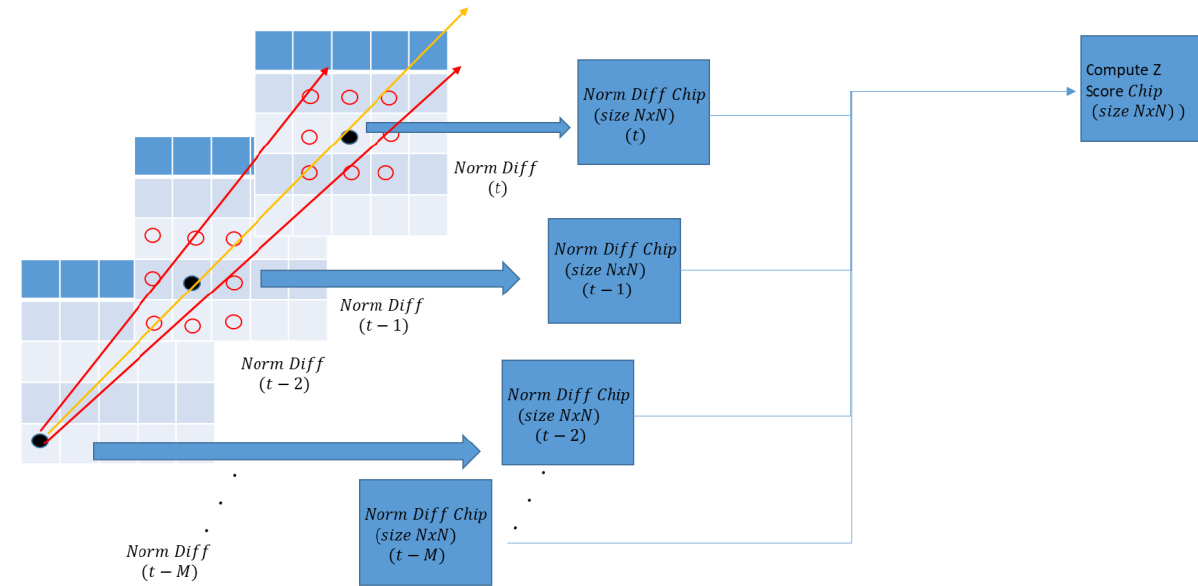
Figure 7. Motion Path Candidate Evaluation.